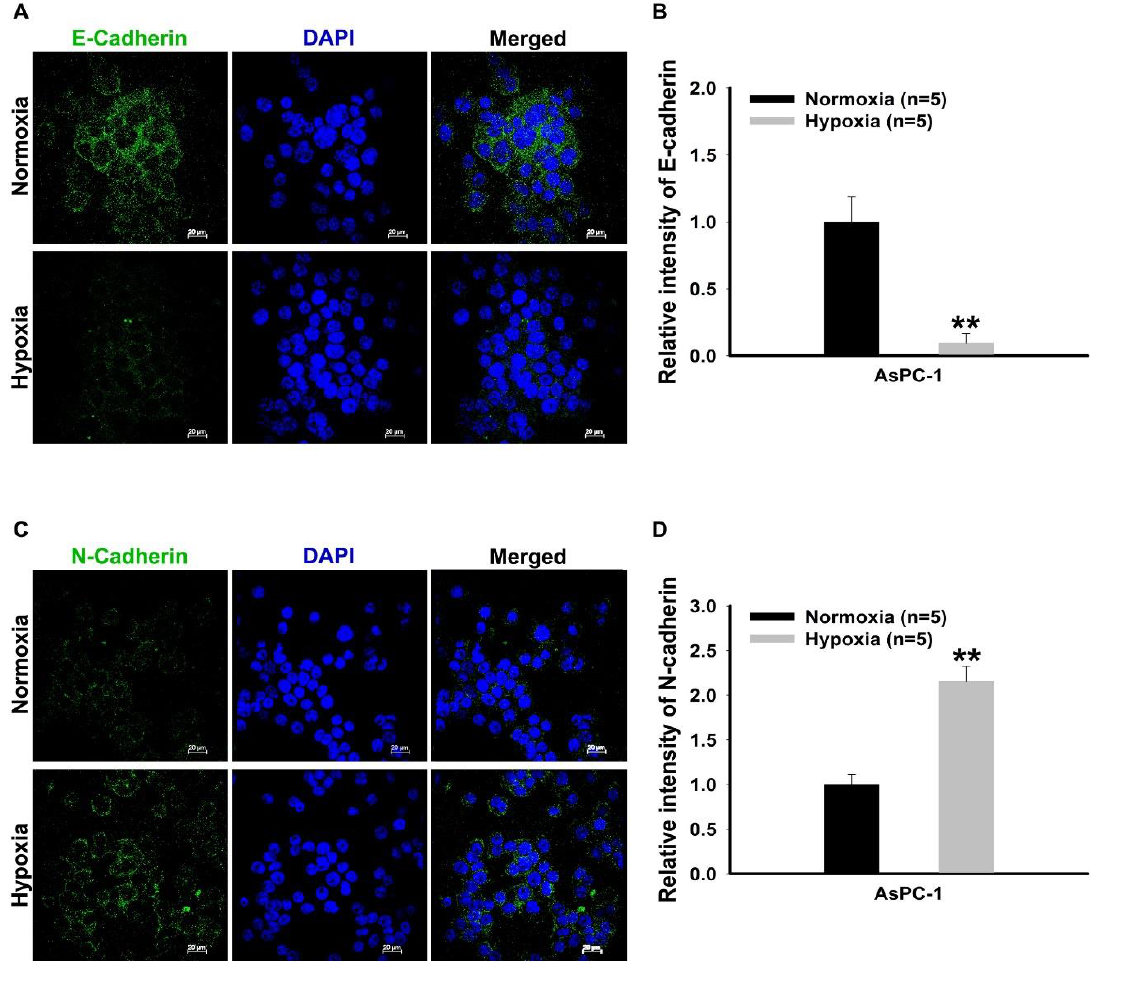
Figure 4. Representative immunofluorescence images for the detection of E-Cadherin and N-Cadherin in pancreatic cancer cells. ( A , C ) Immunofluorescence staining detection of E-Cadherin and N-Cadherin. Each pixel exposure time 0.1 s. Scale bar = 25 µ m ( B , D ). Quantitative analysis for mean fluorescence intensity of E-Cadherin and N-Cadherin comparing between normoxia and hypoxia. The results were performed by quintuplicate obtaining repetitive results. A total of five cells with relatively high fluorescence intensity on one slide of each group was considered as a single analysis. ** P < 0.001 vs. normoxia. Results are mean ± SD.